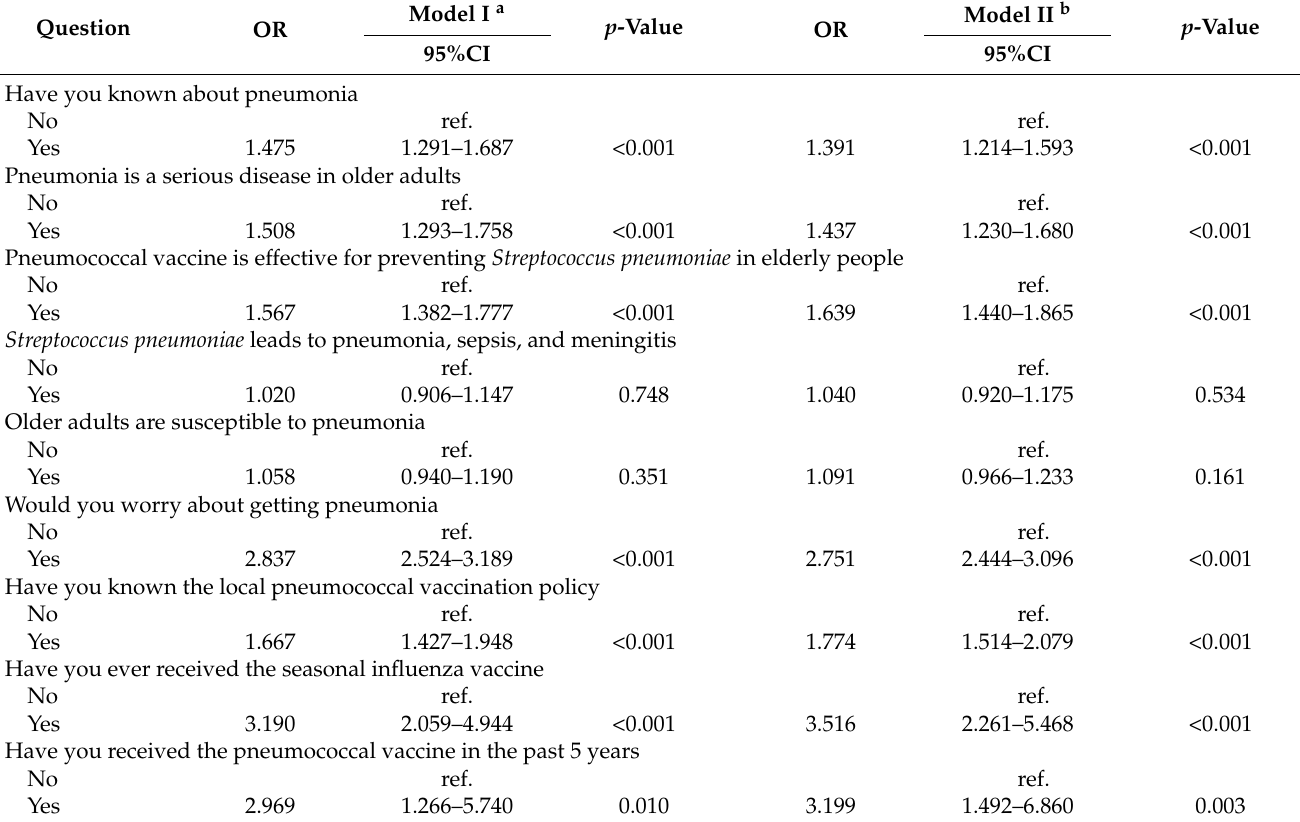
Table 3. Factors associated with the willingness to accept pneumococcal vaccine in the elderly